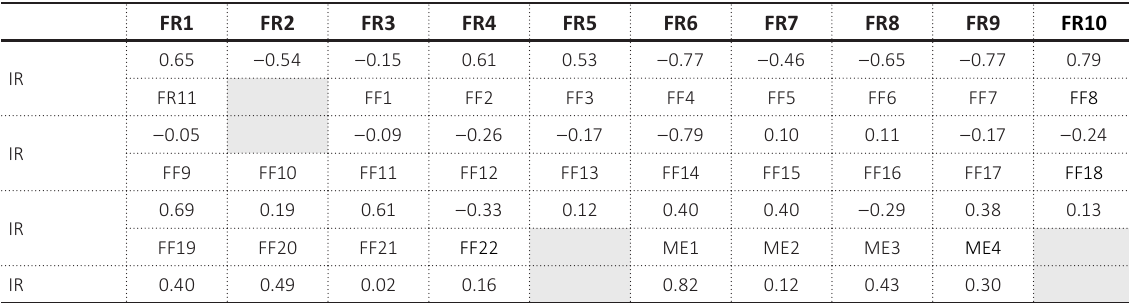
Table 2. Matrix of paired correlation coefficients